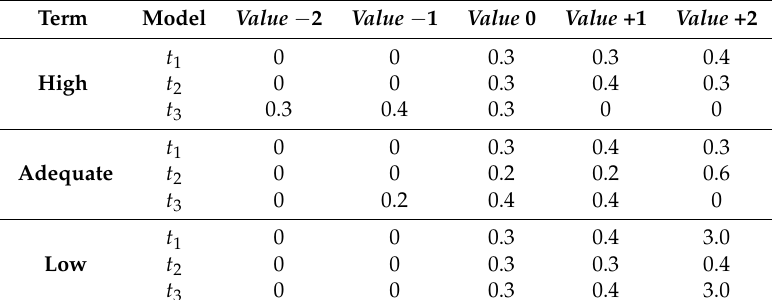
Table 2. The columns are related in order of: (1) term; (2) model; and the percentage of responses for: